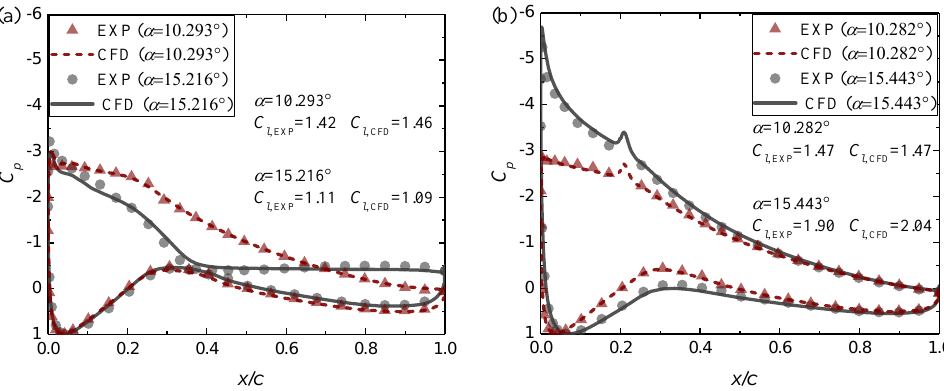
Figure 4. Calculated and measured pressure distributions of the DU97-W-300 airfoil with and without VGs. ( a ) Without VGs; ( b ) with VGs ( x VG / c = 20%).